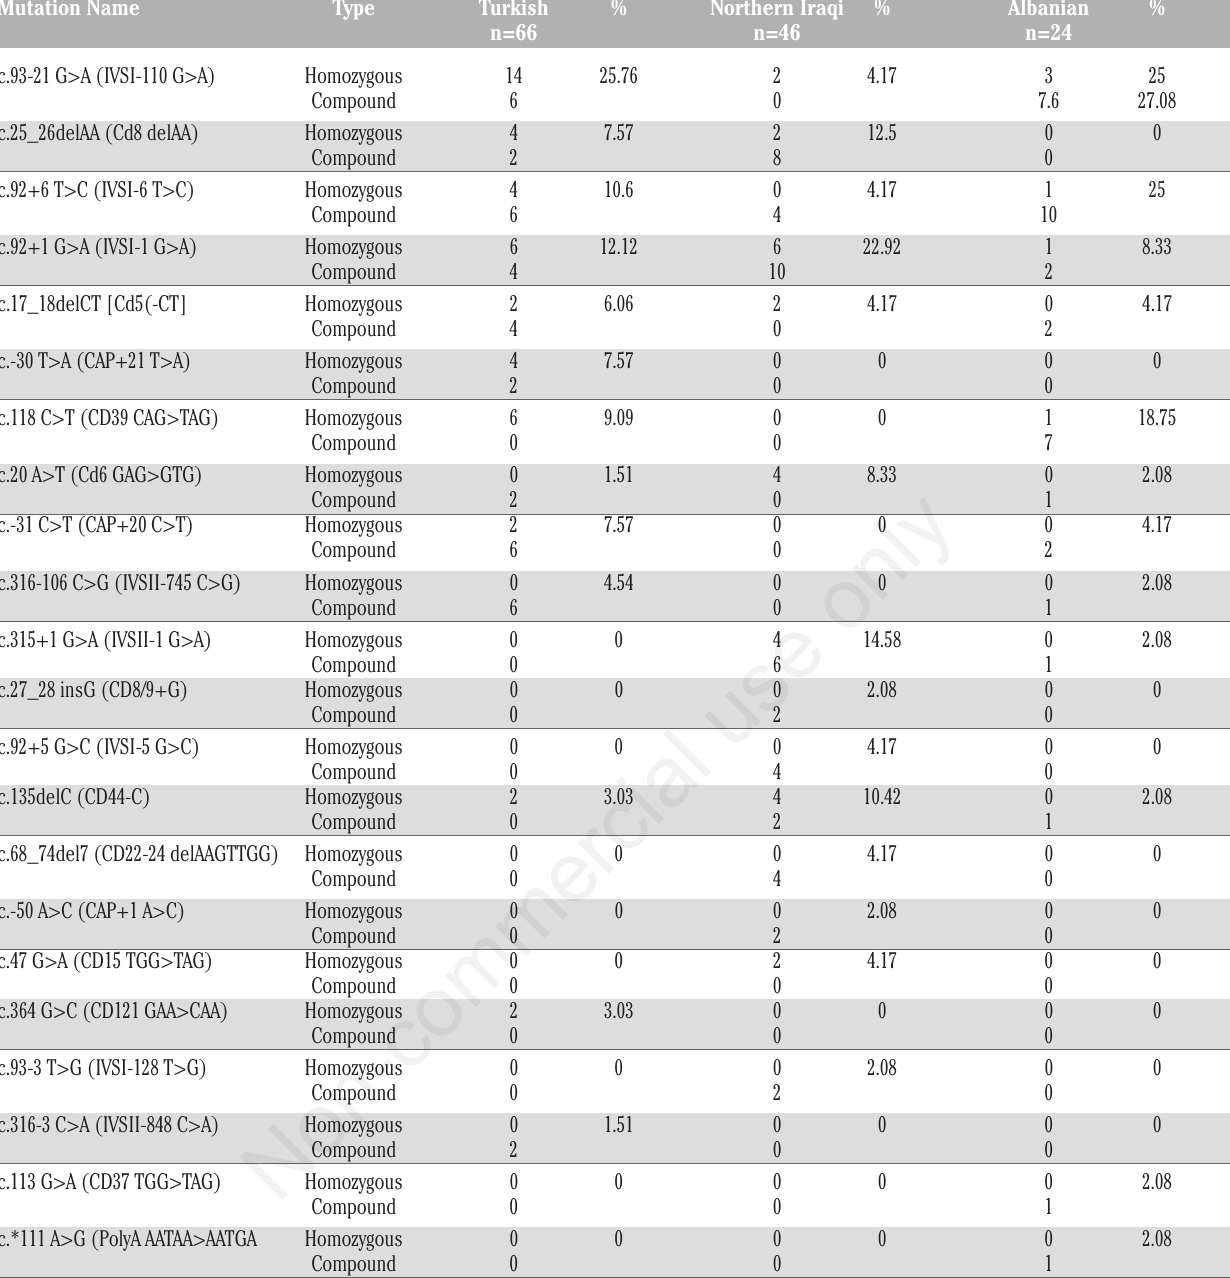
Table 2. Distribution of detected mutations. Mutation